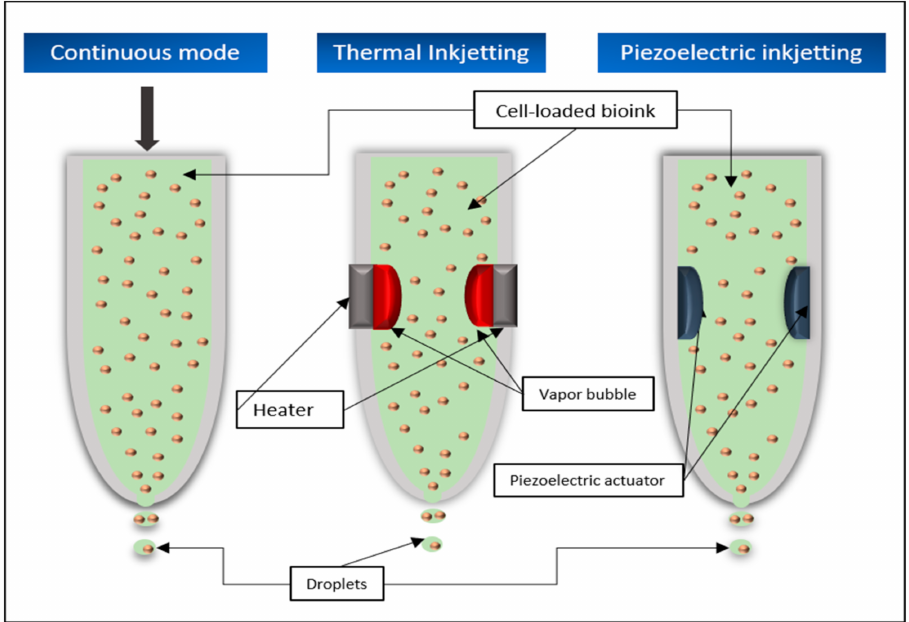
Figure 7. Schematic representation of various material jetting-based printing technologies. All processes rely on the printing material being sprayed drop by drop from a